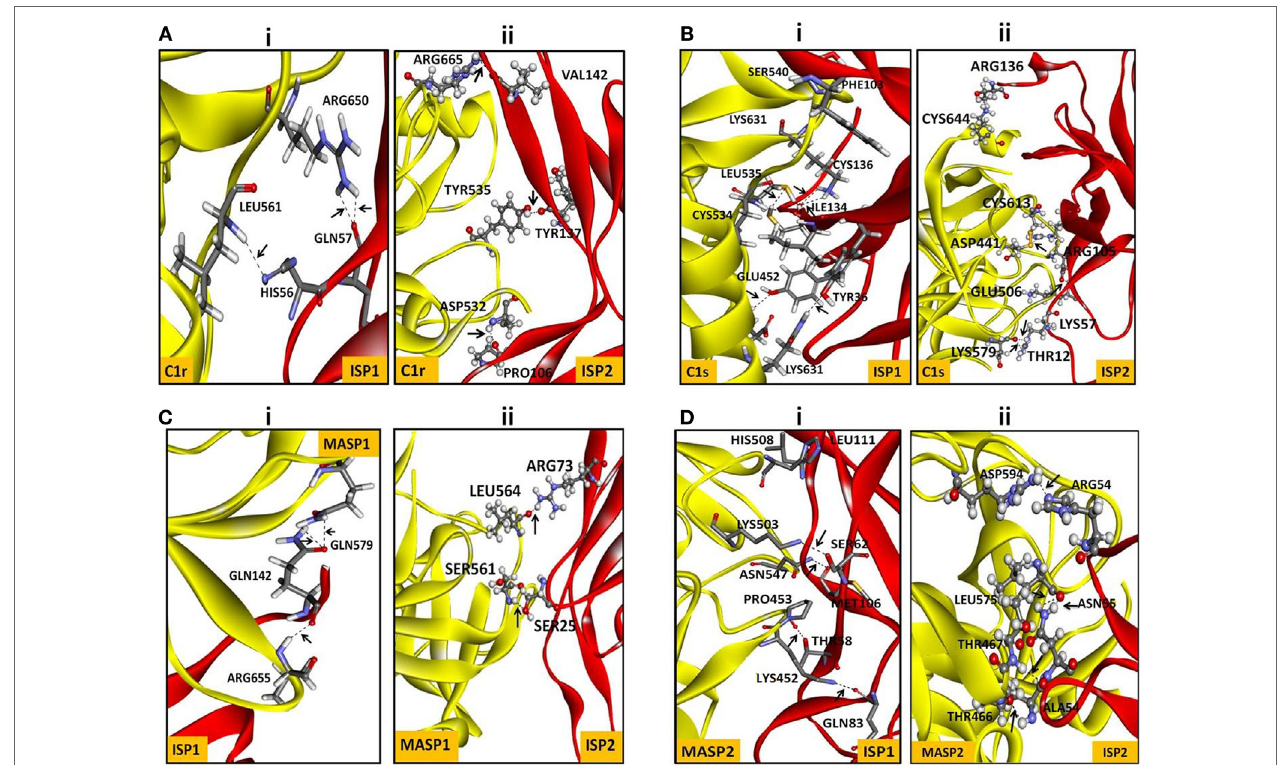
FigUre 1 | In silico interaction of ISP1 and ISP2 with C1r, C1s, MASP1, and MASP2. Homology model of L. donovani ISP1 and ISP2 proteins was obtained from our previous report (24). The interaction of ISP1 and ISP2 proteins with C1r, C1s (a,B) as well as with MASP1, MASP2 (c,D) was performed by GRAMM -X (Web Server v.1.2.0 program) software. The ISP1 interaction was shown as stick whereas ISP2 interaction was represented as ball and stick. Hydrogen bond interactions were shown as dotted black lines with an arrow